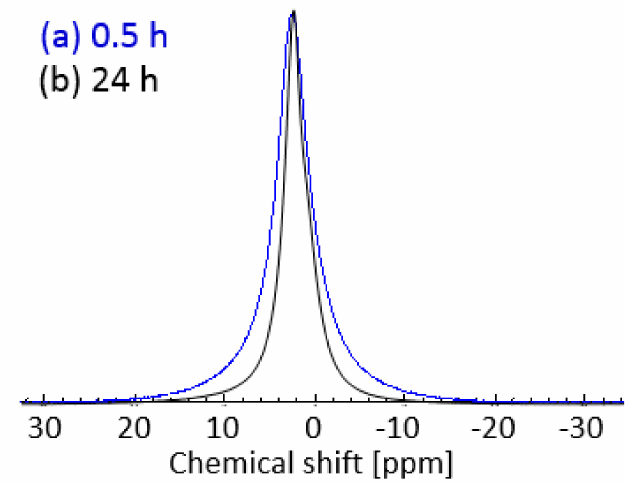
Figure 7. 1 H-NMR spectra of gelatin sample with 20% DES prepared using a setting time of ( a ) 0.5 h and ( b ) 24 h at 21 ◦